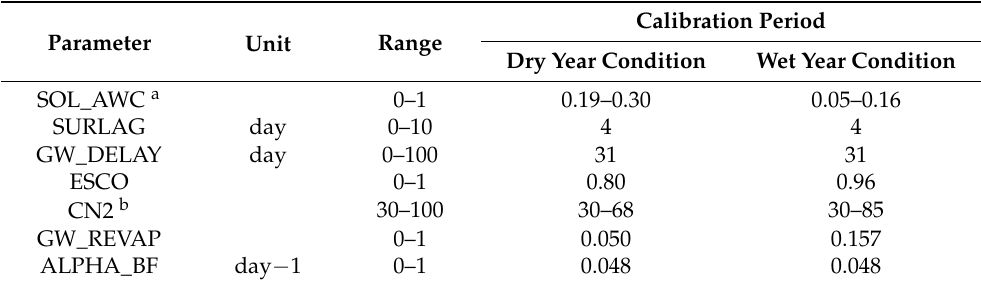
Table 13. Optimal parameter values of SWAT model for hydrologic component estimation under dry and wet year conditions.